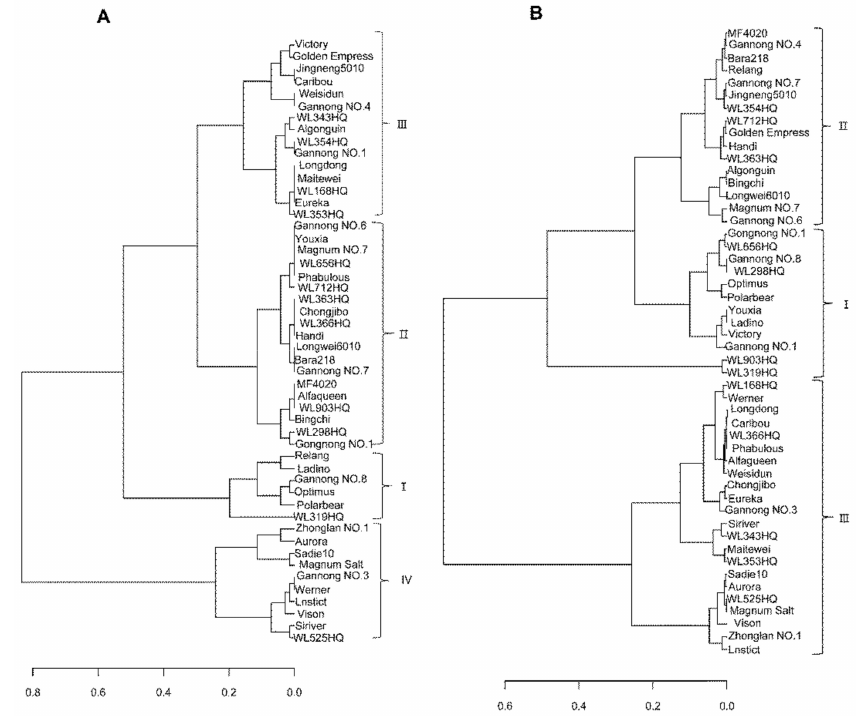
Figure 4. Clustering of the saline-alkaline (SA) tolerance in the 50 alfalfa cultivars based on the two methods. ( A ) Traditional method, ( B ) New